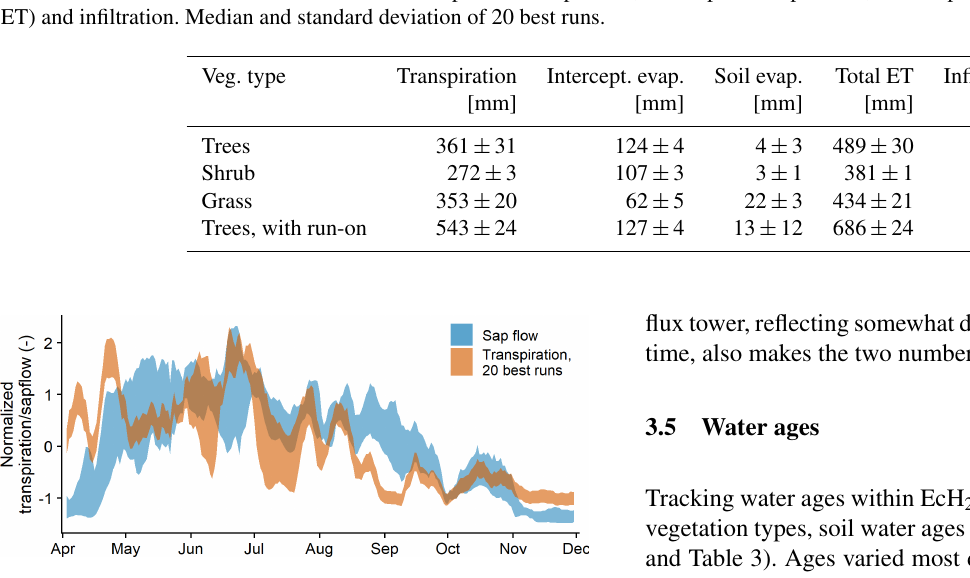
Figure 7. Measured sap flux density (average of six trees) and simu- lated transpiration. Both time series were normalized and smoothed with a 7d moving average to facilitate visual